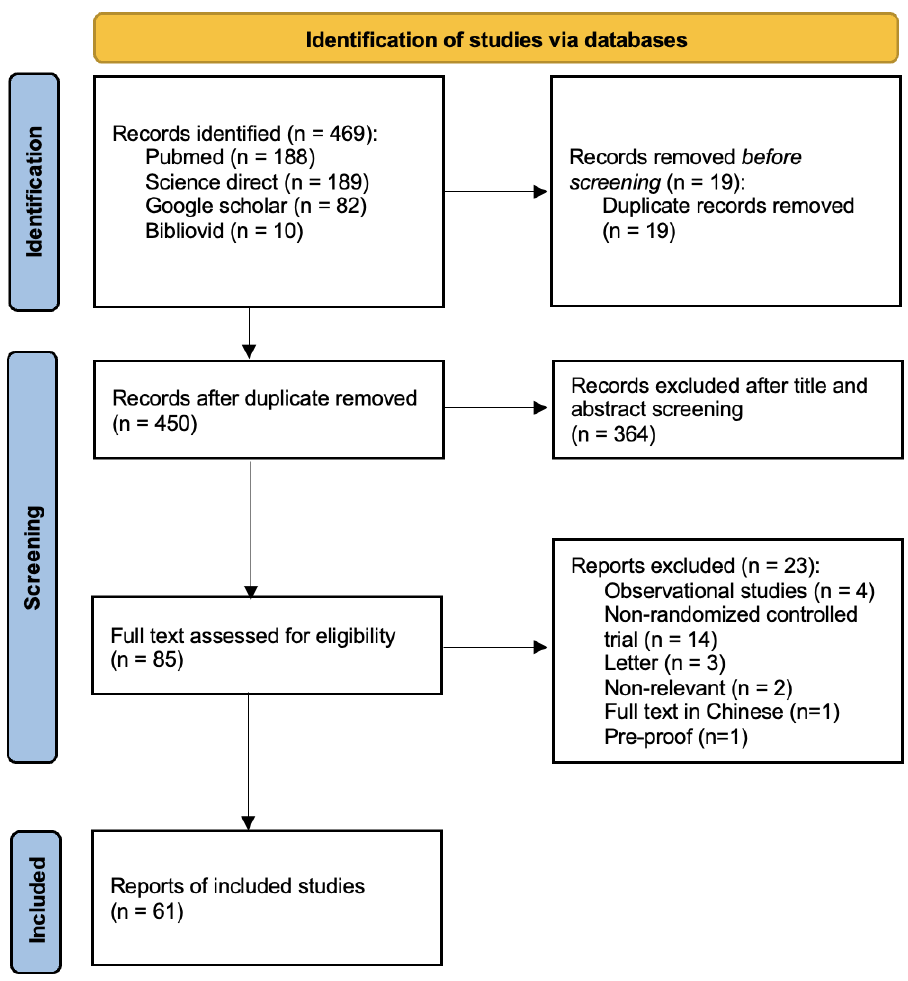
Figure 1. Preferred Reporting Items for Systematic Reviews and Meta-Analyses (PRISMA) flow diagram of the study selection process .